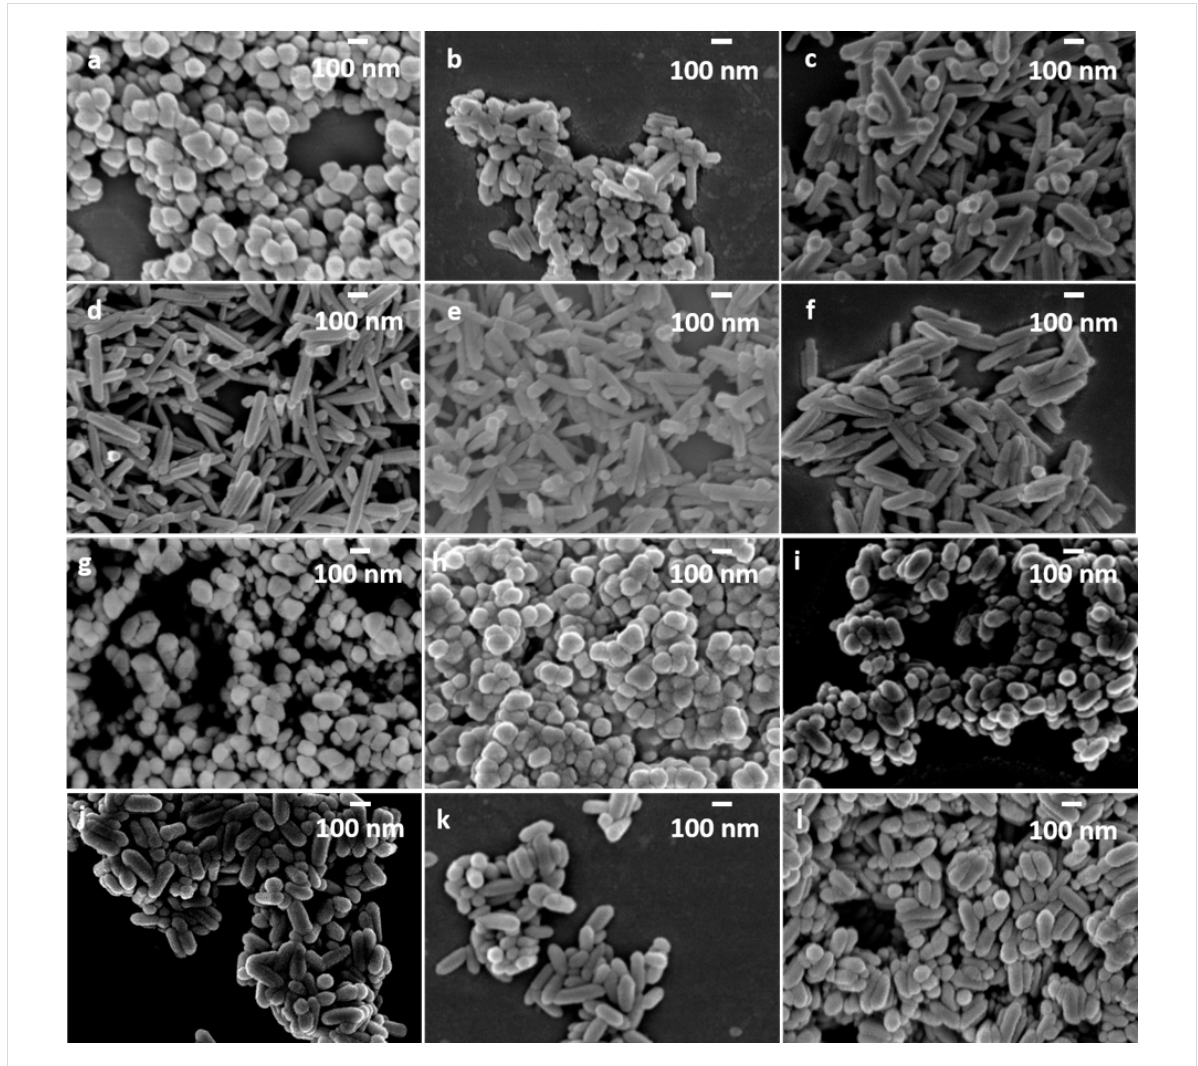
Figure 3: FESEM images of α -Fe 2 O 3 nanoparticles obtained with 1,2-diaminopropane as the SCA and varied Fe 3+ concentration of a) 0.1 M, b) 0.5 M, c) 0.8 M, d) 1.0 M, e) 1.5 M and f) 2.0 M; and α -Fe 2 O 3 nanoparticles obtained with ethylenediamine as the SCA and varied Fe 3+ concentra- tion of g) 0.1 M, h) 0.5 M, i) 0.8 M, j) 1.0 M, k) 1.5 M and l) 2.0 M; magnification: